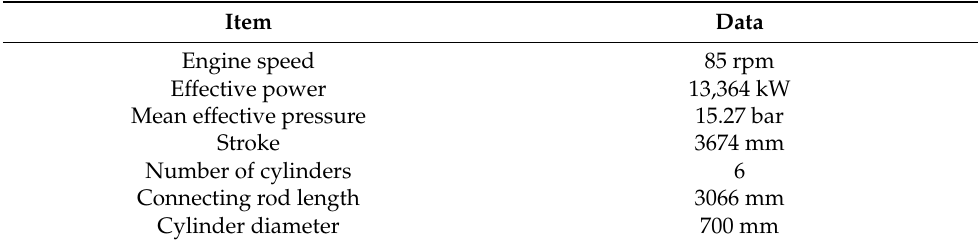
Table 1. Test engine parameters and specifications.